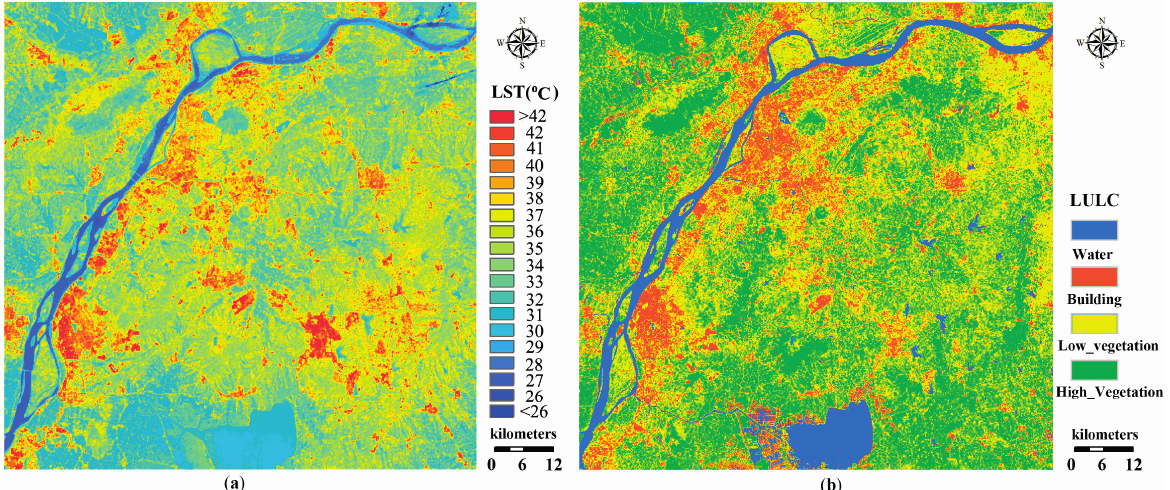
Figure 7. ( a ) The retrieved LST image retrieved by the mono-window algorithm with Band 10 of the region on August 11, 2013; ( b ) the land use and land cover (LULC)